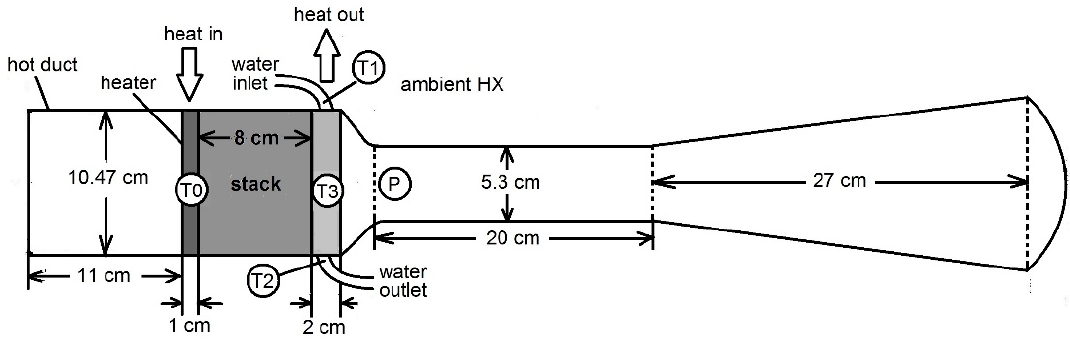
Figure 1. Schematic of the standing wave test engine. Labels “T” indicate thermocouple locations. Label “P” indicates microphone location.